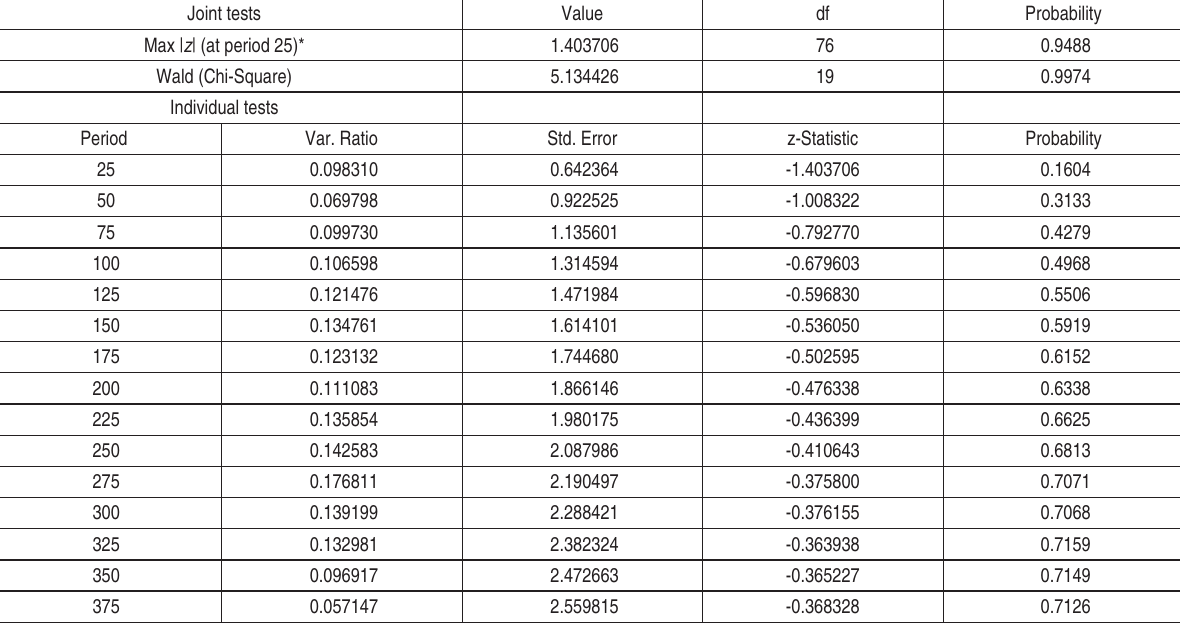
Table 6. Results of the variance ratio test DSE ALSI weekly